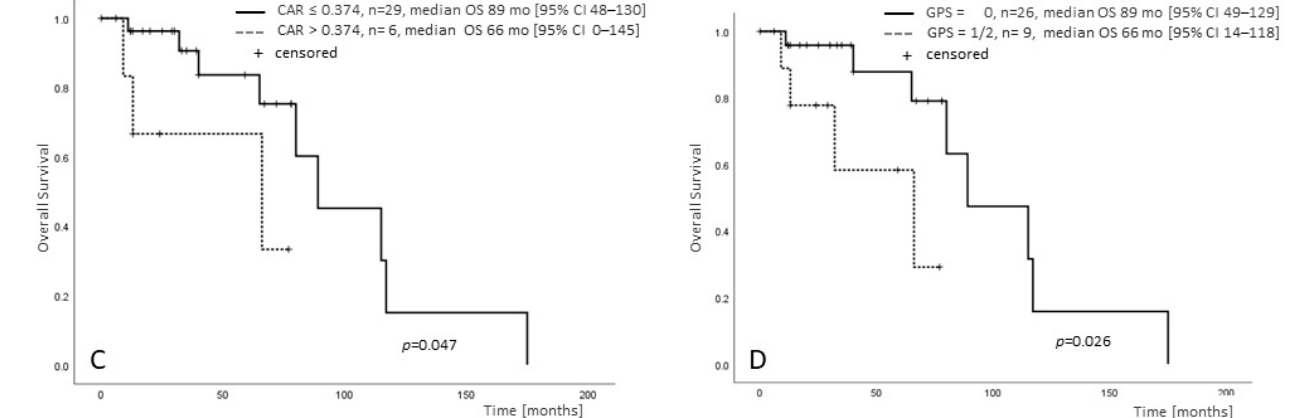
Figure 2. Albumin and CRP provide MIPSS70-independent prognostic information in MF. Survival of MIPSS70-intermediate-risk patients, for whom both albumin and CRP were available (n = 35), stratified by albumin </ ≥ 40 g/L ( A ), CRP ≤ /> 8 mg/L ( B ), CRP/albumin ratio ≤ /> 0.374 ( C ) and GPS </> 0 ( D ).